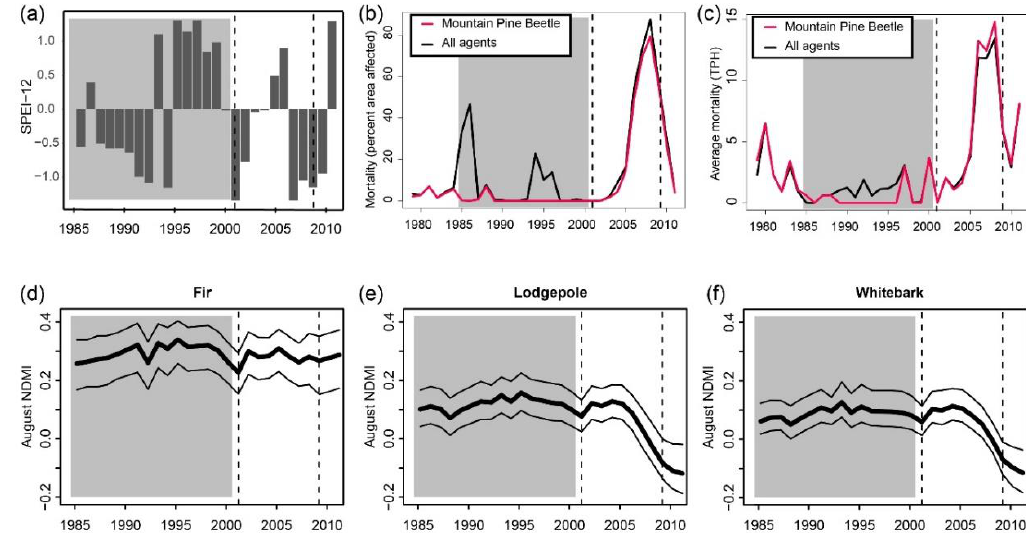
Figure 3. Time series of ( a ) Standardized Precipitation Evapotranspiration Index calculated with 12-month antecedent conditions (SPEI-12); ( b ) areal percent of the study area affected by tree mortality from mapped insect and disease agents; ( c ) severity (in mean trees per hectare, TPH) for areas affected by mortality; ( d – f ) August values of Normalized Difference Moisture Index (NDMI) by forest type, including median value (bold line) and interquartile range (thinner lines). In all plots, the reference period 1985–2000 is shaded gray and the two drought years selected for analysis (2001 and 2009) are marked with dashed vertical lines. In ( b ), the mortality spike in the mid-1980s was attributable to Modoc budworm ( Choristoneura viridis ); the spike in the mid-1990s was attributable to fir engraver ( Scolytus ventralis ).